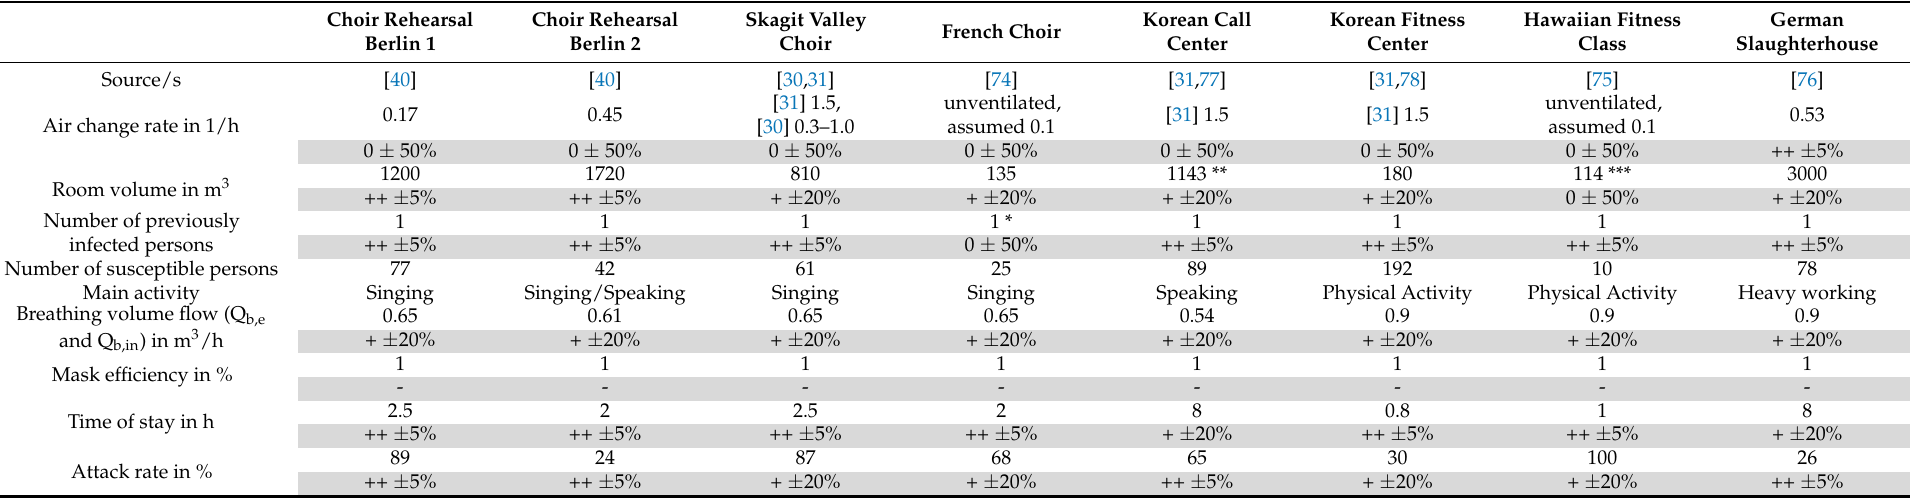
Table A2. Scientifically published SARS-CoV-2 outbreaks.